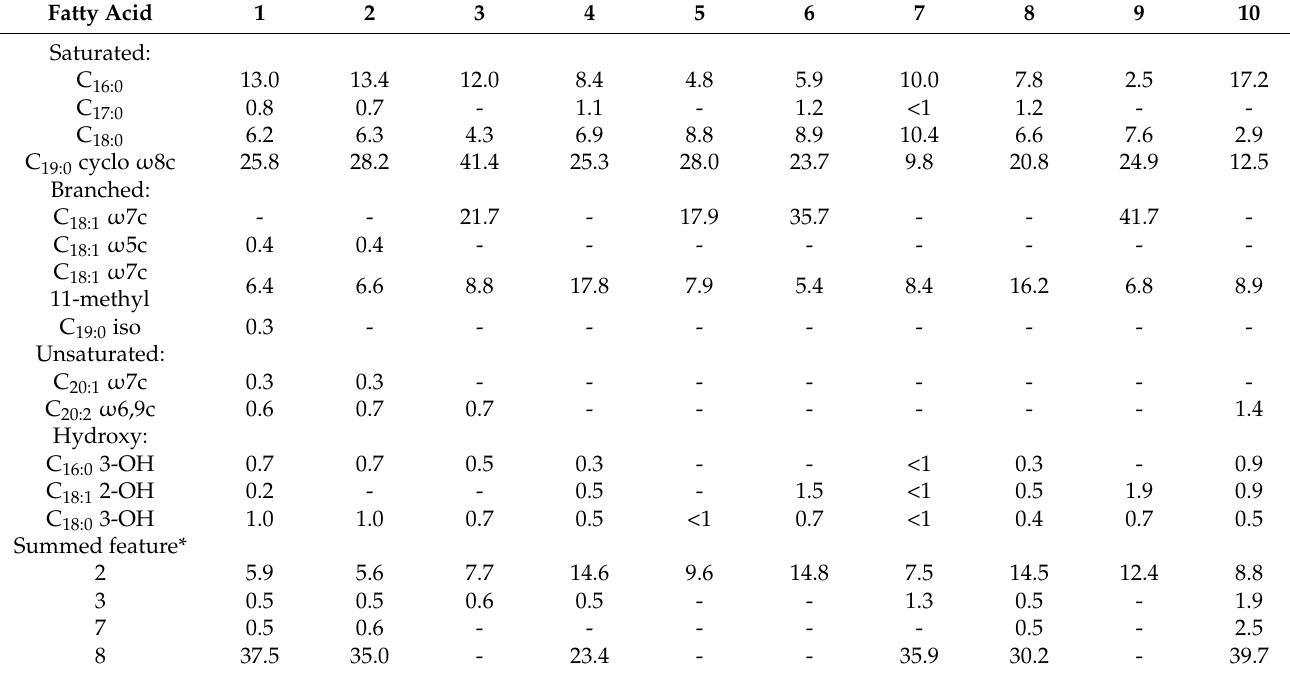
fatty acid profiles of strains NC18 T and NC20 had similar patterns to those of members of the genus Martelella . However, there were some differences in the respective compositions of some long-chain fatty acids, such as C18:1 ω 5c, C19:0 iso, and C20:1 ω 7c. The respiratory quinones of strains NC18 T and NC20 were Q-10, typical for the genus Martelella [1–6]. Table 2. Cellular fatty acid compositions (%) of strains NC18 T and NC20 with related taxa within the genus Martelella